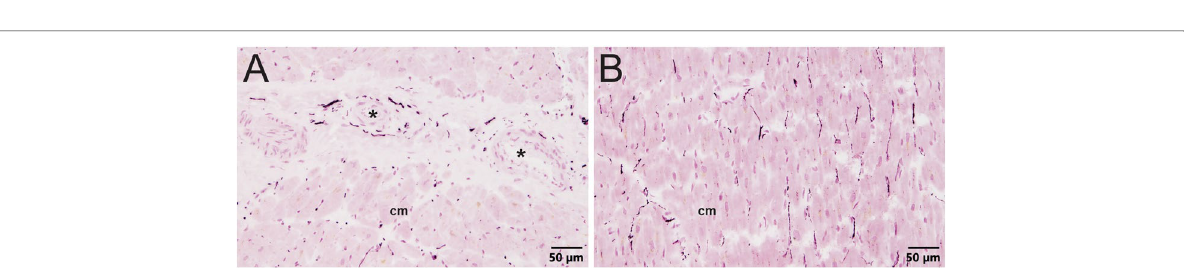
Fig. 5 Localization of noradrenergic nerves in normal human left ventricle. A Sympathetic nerves occur in the adventitia of a coronary artery (*) and appear as puncta around cardiac myocytes (cm) cut in cross section. B TH